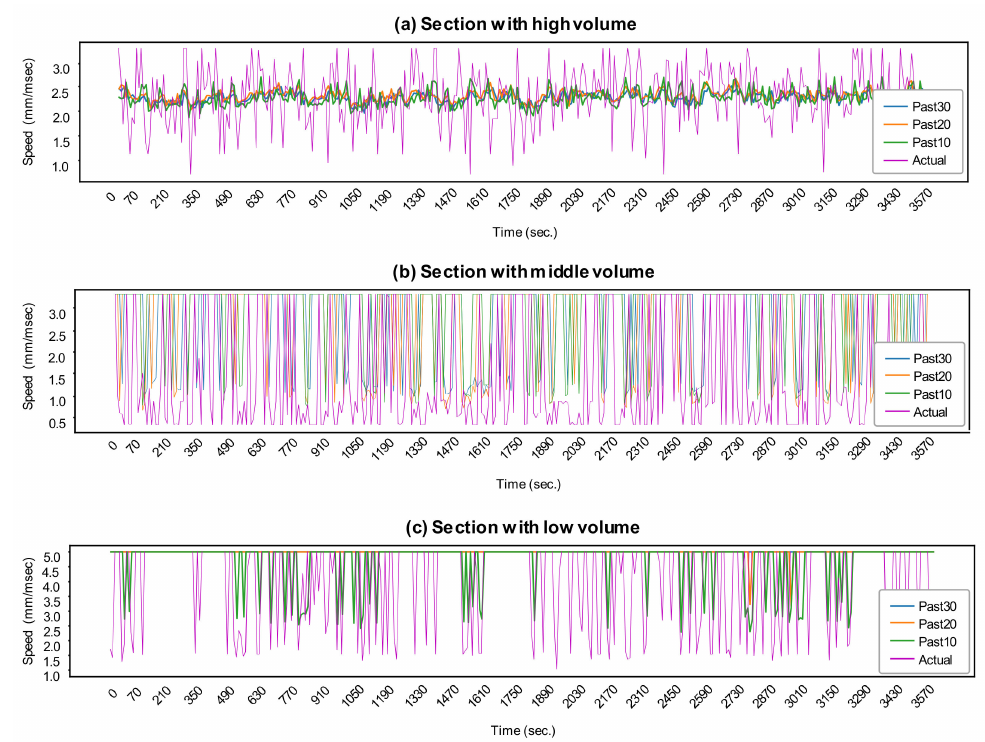
Figure 6. Time series graph of predicted and actual values for each time interval; ( a ) section with high volume, ( b ) section with medium volume, and ( c ) section with low